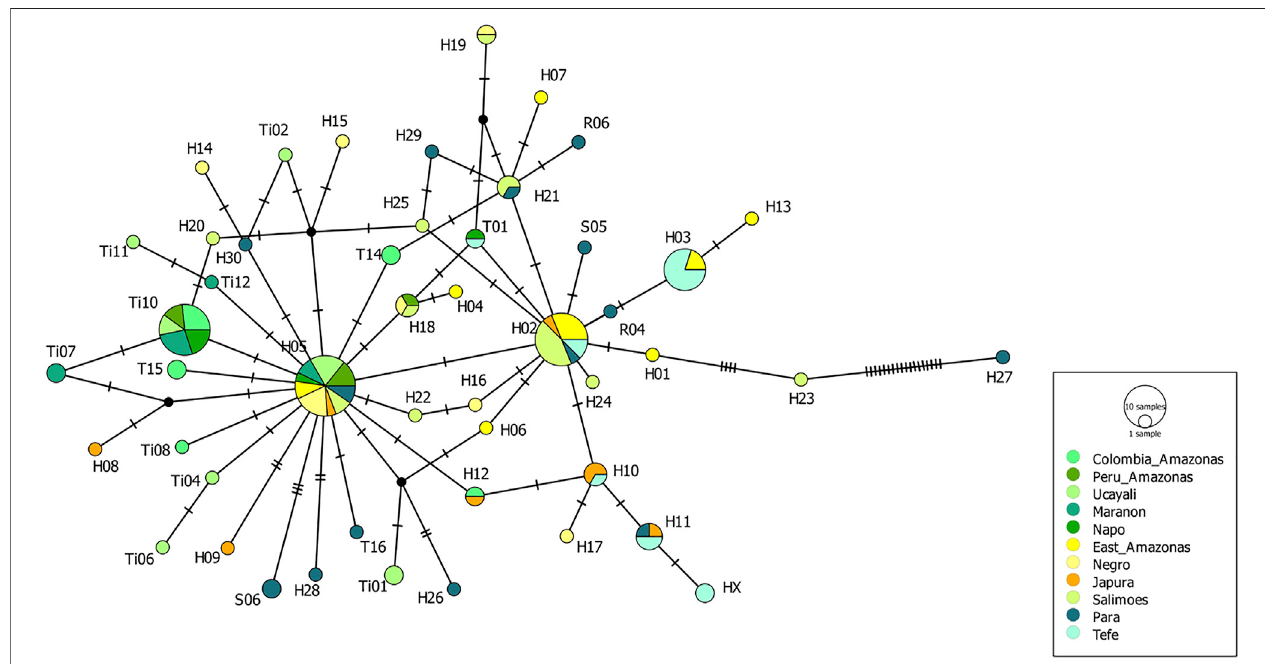
FIGURE 5 | Haplotype network for Trichechus inunguis from the Colombian Amazon as well as from the Peruvian and Brazilian Amazon, obtained from the TCS analysis. The size of the circle represents the frequency of each haplotype.